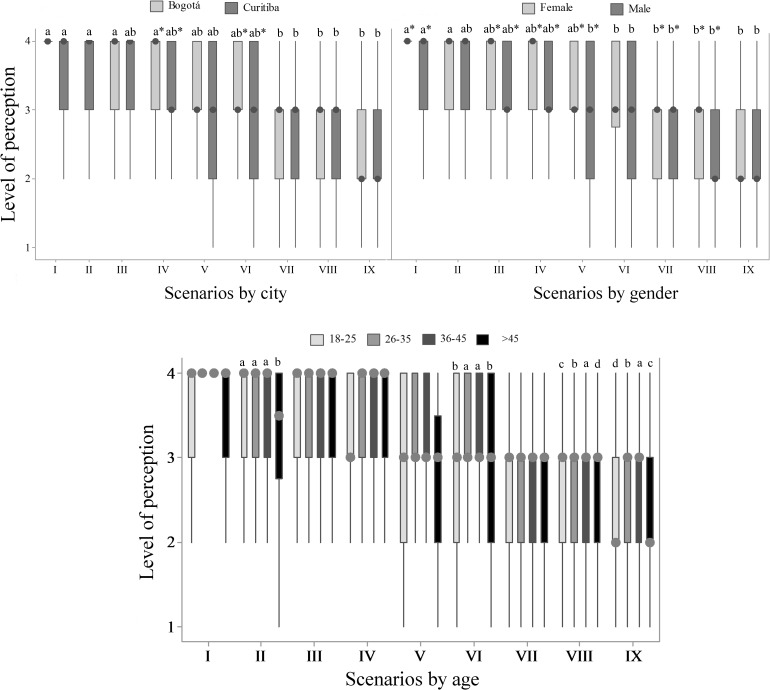
Perceived level of suffering in different scenarios (Q7) by 782 citizens of Bogotá and Curitiba, 2014/2015.Data for city, gender and age; 1 = none and 4 = a lot; (I) Fishing with hook and line, (II) Municipal live fish fair, (III) Fish-and pay ponds, (IV) Fish kept as laboratory animals, (V) Fish farming, (VI) Fish in pet stores, (VII) Production of ornamental fish, (VIII) Fish in aquarium exhibits, (IX) Fish kept as pets; the asterisk indicates city and gender difference (P<0.05, Mann-Whitney); letters indicate differences between scenarios and age groups (P<0.05, Kruskal-Wallis and Dunn Test).